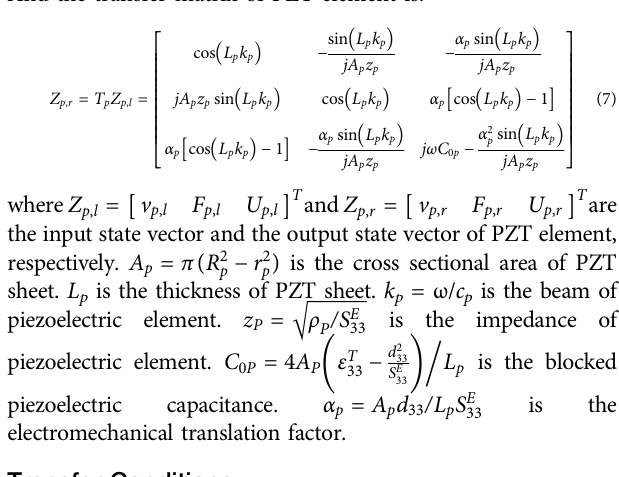
The right amplitude modulator (R 1 ∼ R 4 ) and the left